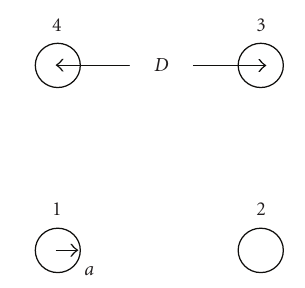
Figure 11: Top view of a four-monopole antenna ( a = 0 . 8mm, h = 29mm).